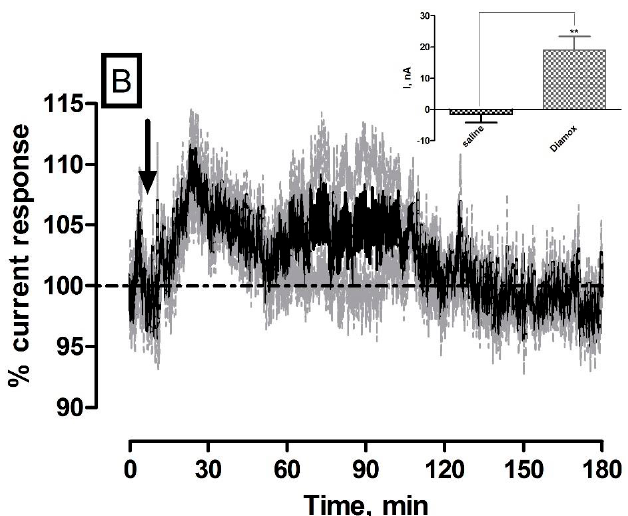
Figure 4. Averaged raw data % current response of O 2 sensors implanted in the striatum of NOD SCID mice to a ( A ) 350 mg · kg − 1 injection of chloral hydrate ( n = 5) and ( B ) 50 mg · kg − 1 injection of Diamox. Arrows indicate point of injection. Mean % current response represented by black trace, % error represented by grey trace. Insets: Comparison of ∆ I for ( A ) saline control vs. chloral hydrate ( p < 0.01), unpaired t -test ( n = 5) and ( B ) saline control vs. Diamox ( p < 0.01), unpaired t -test ( n = 5). Data represented as ∆ I ± SEM as compared to baseline. * denotes level of significance